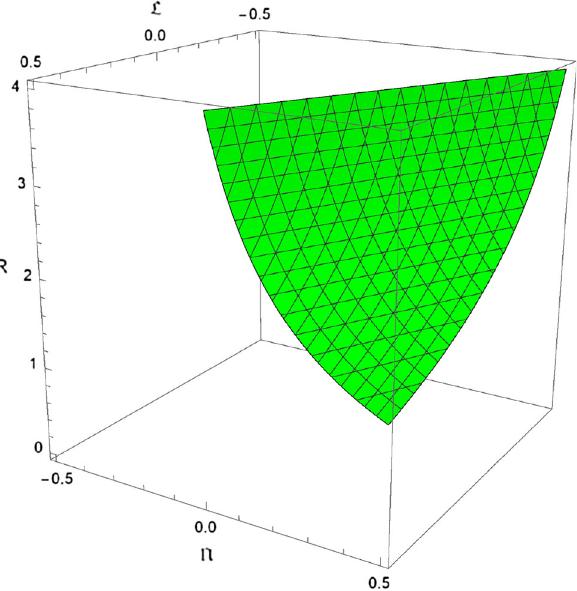
Fig. 3 The variation of D s and N d ( u ) parameters for the dust background